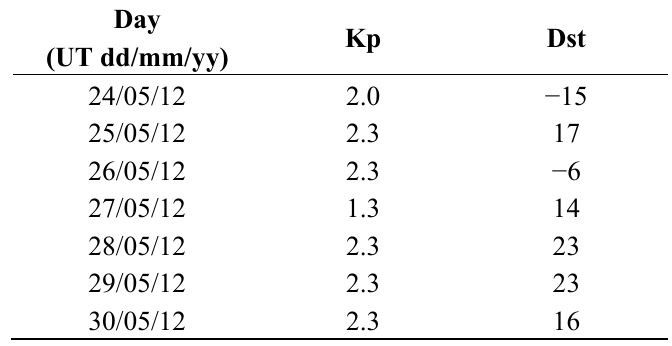
Table 1. Dates analyzed to determine detection